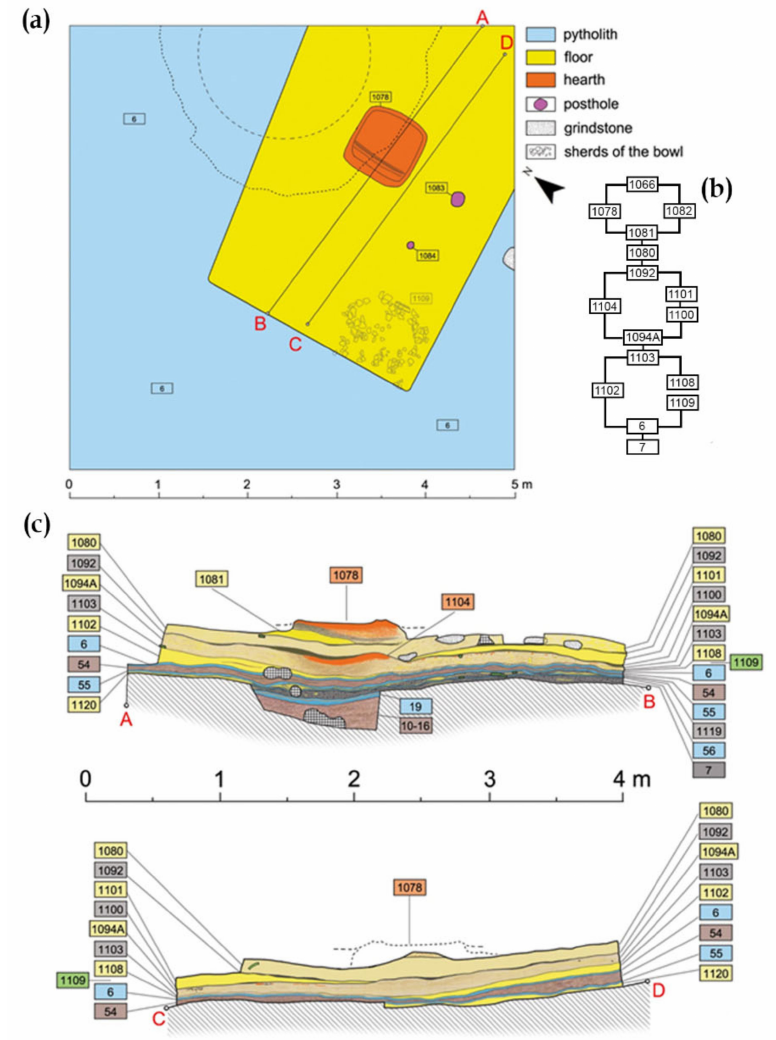
Figure 4. ( a ) Reconstructed layout of house A with the marks of the profiles. ( b ) Harris matrix of the house A layer sequence. ( c ). Profile of house A with two main occupation periods. From North (A,B) and South (C,D). Modified from Fischl et al. 2022